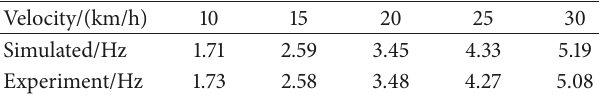
Table 3: Simulated dominant frequency of car body acceleration. Velocity/(km/h) 10 15